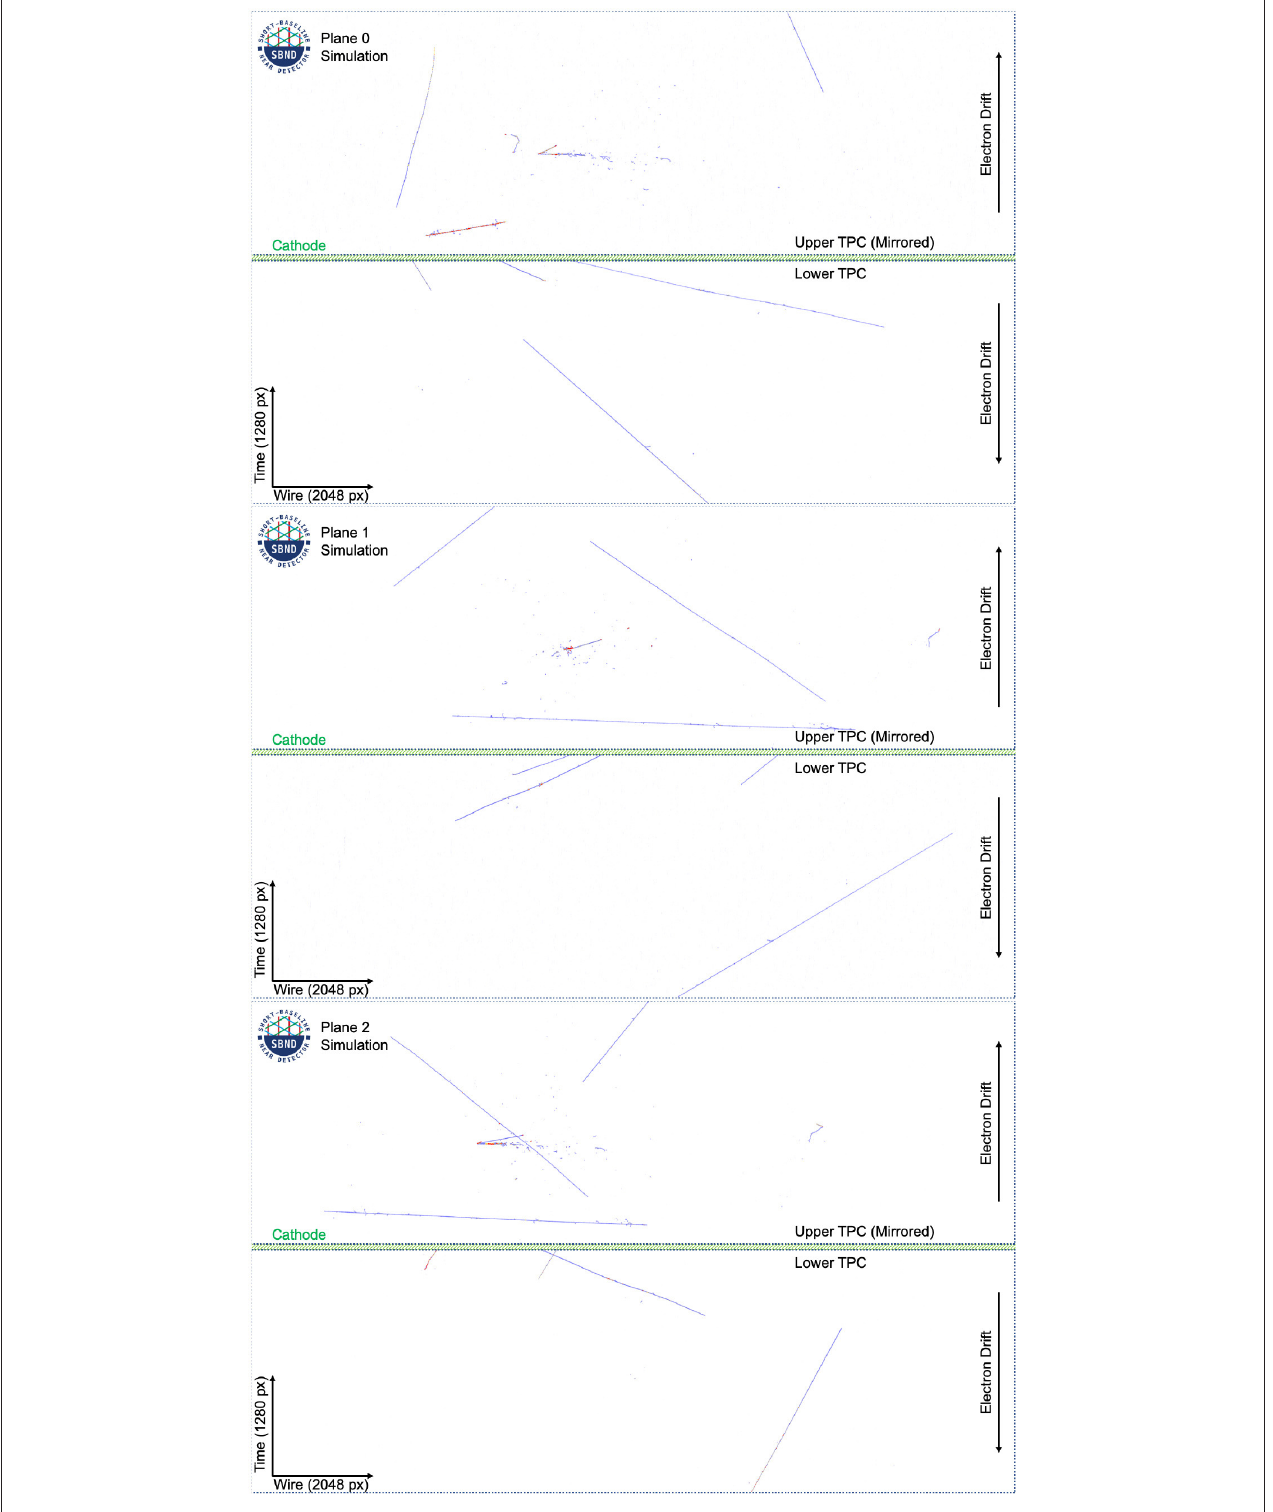
FIGURE 4 | The raw data for one image in the dataset at full resolution. Charge observed is colored with blue for smaller charge depositions and red for larger charge depositions. There is an electron neutrino charged current interaction in the Upper TPC.